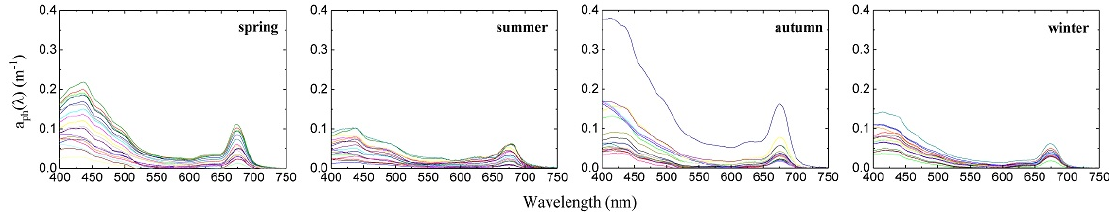
Figure 11. Phytoplankton absorption spectra in Lake Qiandaohu for each season. The curves with different colors in each panel represent different sampling sites.